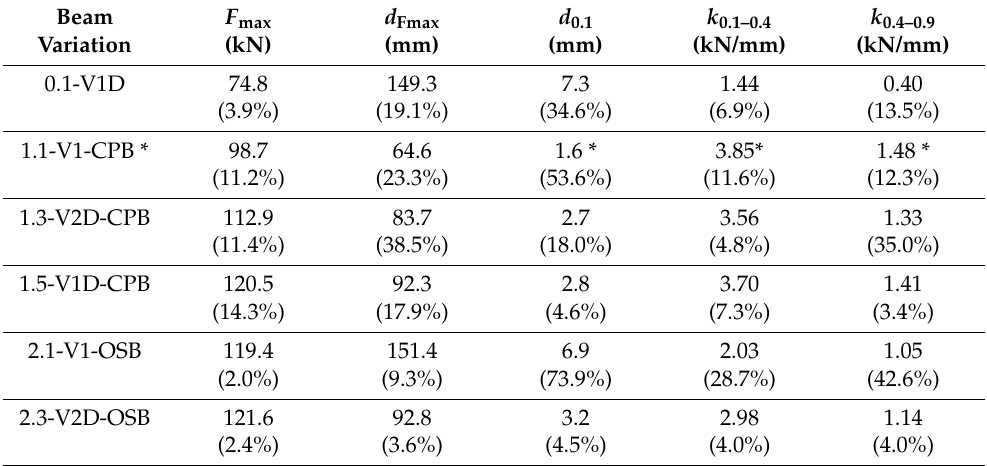
Table 3. Average results for different variations of beams with CV for each parameter in brackets.